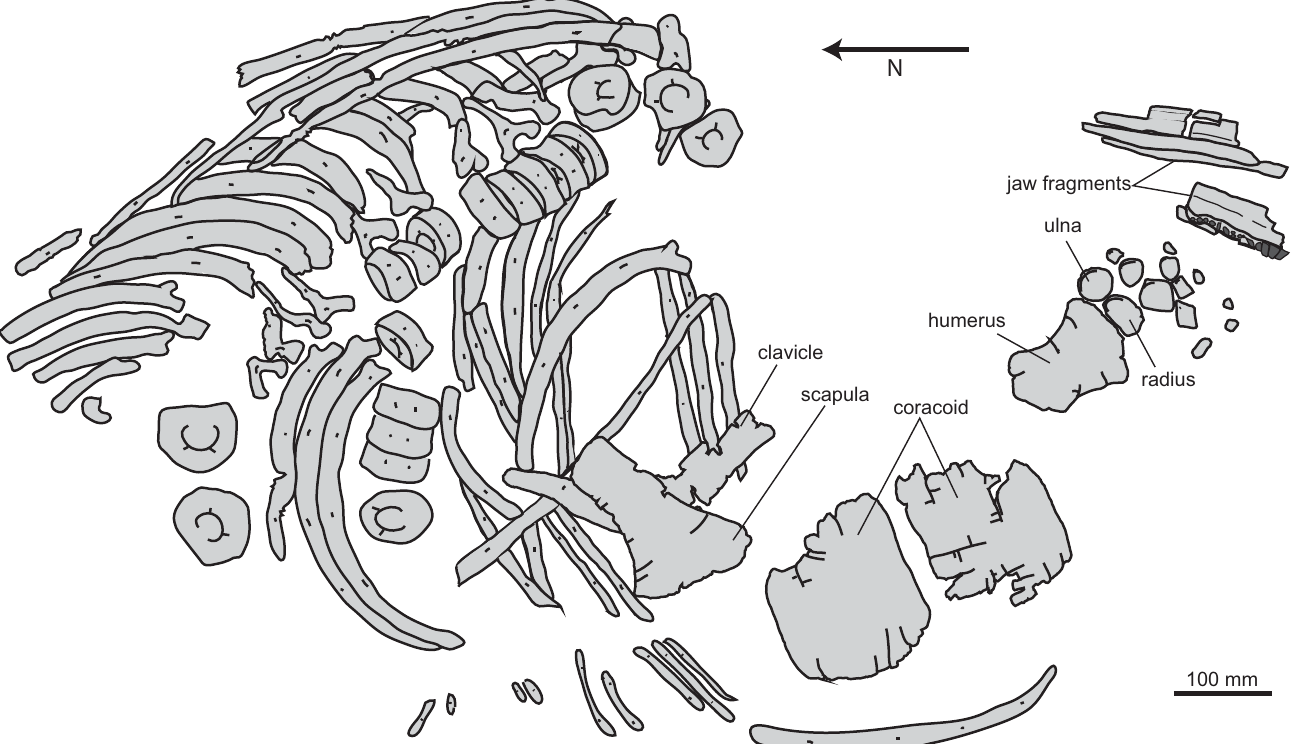
Fig. 3. Explanatory drawing of the skeleton of ophthalmosaurid ichthyosaur Keilhauia sp. ( PMO 222.667) from Spitsbergen, Svalbard, Slottsmøya Mem- ber Lager stätte, Tithonian. Modified and corrected from Delsett et al.